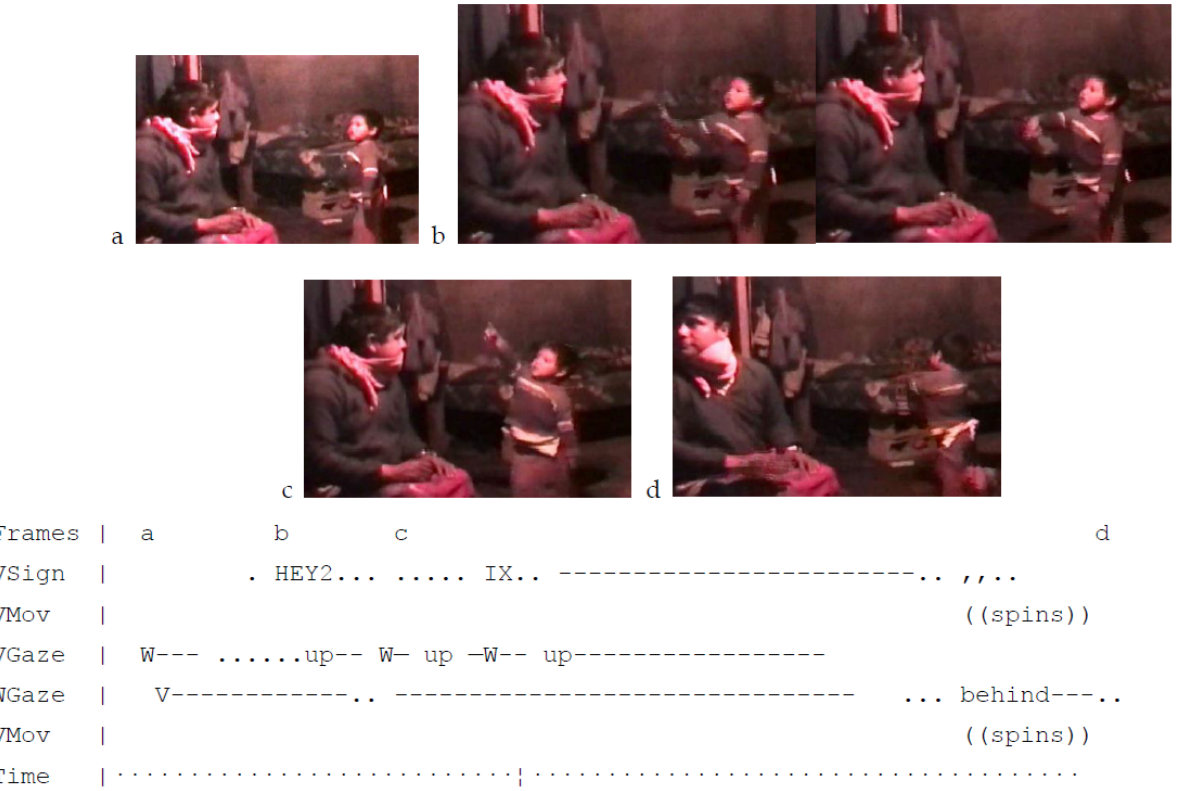
Figure 27. At 35 mos. Vic played with his uncle Will. From a safe distance, Vic ( a ) fixed his gaze on his uncle, ( b ) turned his body toward him, and issued a very rapid single downward right-hand flip, HEY2, immediately segueing into ( c ) a rapid right-handed point above and behind Will. ( d ) Will turned to gaze in that direction as young Vic did a playful pirouette (presumably because he was joking about the point in the first place, as his uncle had previously been doing with him). My last example to show Vic’s developing use of the fully grammaticalized HEY2 sign comes from an extended interaction when he was 41 months old, as Jane was getting him dressed for an excursion. She was concentrated on one of his socks, when he appar- ently spied the clean shirt she had placed on the ground to put on him (Figure 28). The whole sequence can be glossed, “Hey, I have two of those [shirts]; go get me the other one that is outside.”